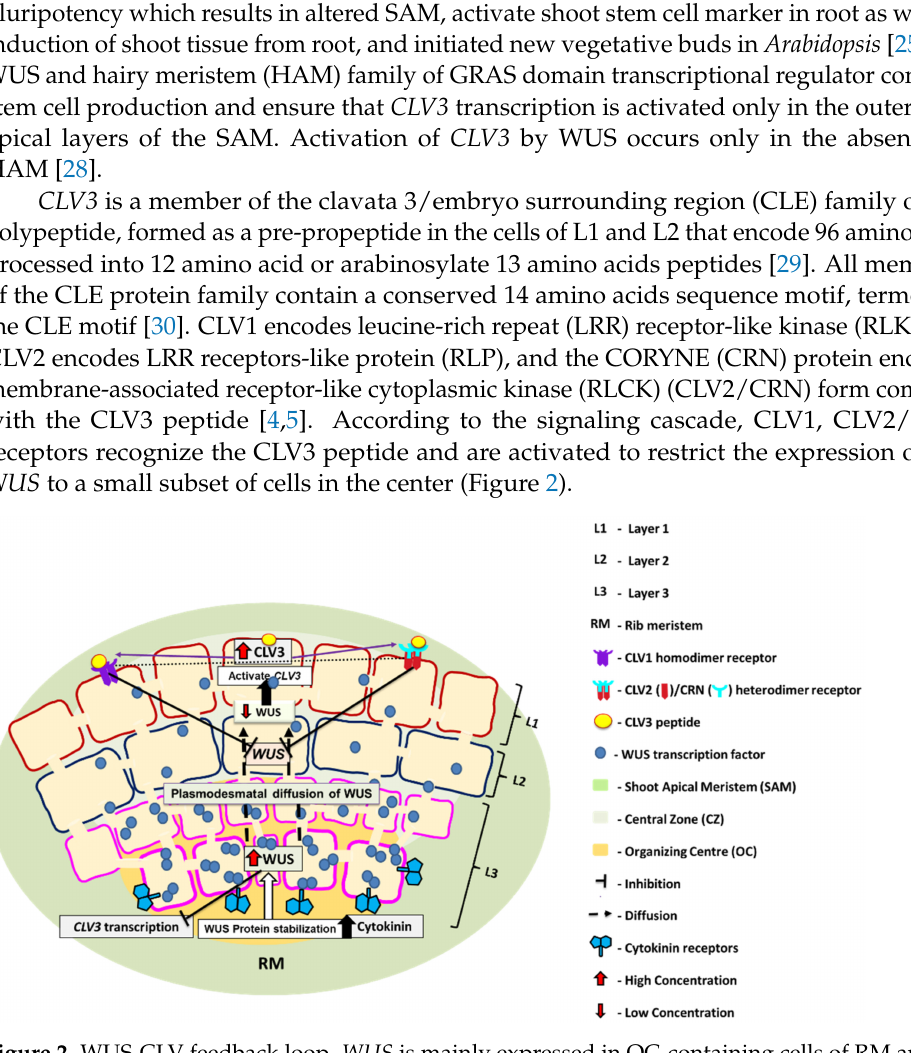
Figure 2. WUS-CLV feedback loop. WUS is mainly expressed in OC-containing cells of RM and L3. WUS acts non-autonomously in L1 and L2. High levels of WUS are maintained by high cytokinin concentration and absence of CLV3 suppression on WUS transcription. At higher concentration of WUS, it represses CLV3 transcription in L3 and RM. WUS concentration decreases as it moves towards the apex because of the absence of cytokinin in L1 and L2. At low concentration of WUS, CLV3 transcription is activated. CLV3 then represses the transcription of WUS in L1 and L2 by interacting with homodimer of CLV1 and heterodimer of CLV2/CRN, receptors of CLV3. In this way, WUS-CLV maintains a feedback loop. CLV, CLAVATA; WUS,